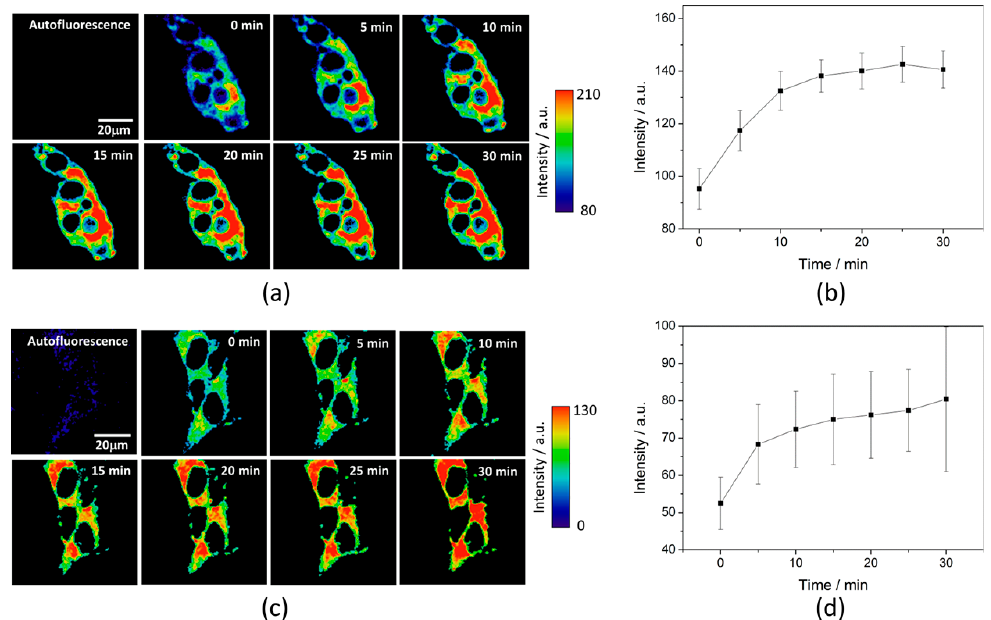
Figure 2. Fluorogenic reaction of DNBS-2Me-4OMe-TM (6 × 10 − 7 M) in response to intracellular biothiols. ( a ) Representative example of fluorescence intensity imaging with time in HepG2 cells, and ( b ) the emission intensity averaged over the pixels in the cytoplasm of 10 repeated experiments containing several cells. Error bars represent the standard errors. ( c ) Representative example of fluorescence intensity imaging with time in the preosteoblasts, and ( d ) the emission intensity averaged over the pixels in the cytoplasm of five repeated experiments. Error bars represent the standard errors. Simultaneously, and by focusing on the fluorescence lifetime, τ , of the released 2Me-4OMe-TM, the intracellular phosphate concentration can be estimated. As it is described by the theory of buffer-mediated ESPT reactions [21,22], the fluorescence lifetime is dependent on the presence of an adequate proton/donor acceptor as the phosphate buffer. For this ESPT reaction to occur, the 2Me-4OMe-TM must undergo an acid-base equilibrium with a p K a value that, optimally, matches that of the proton donor/acceptor buffer. Indeed, we obtained that the 2Me-4OMe-TM has a neutral, non-emissive form, whose molar absorptivity was 12,300 M − 1 cm − 1 at 499 nm, and a ground-state p K a of 7.26 ± 0.03. To test the capability of the released 2Me-4OMe-TM to report on the intracellular phosphate ions concentration, we opened small pores in the cell membrane using α -toxin, allowing small molecules (such as phosphate ions) to enter and exit freely from the medium to the cell without any loss of high molecular weight cellular compounds. Next, we obtained FLIM images using different extracellular buffers with different phosphate concentrations. Figure 3a,c show FLIM images of the released 2Me-4OMe-TM in HepG2 and preosteoblast cell lines at different phosphate concentrations. Using the arbitrary colour scale (from 4.6 to 3.7 ns) to represent the fluorescence lifetime, it is possible